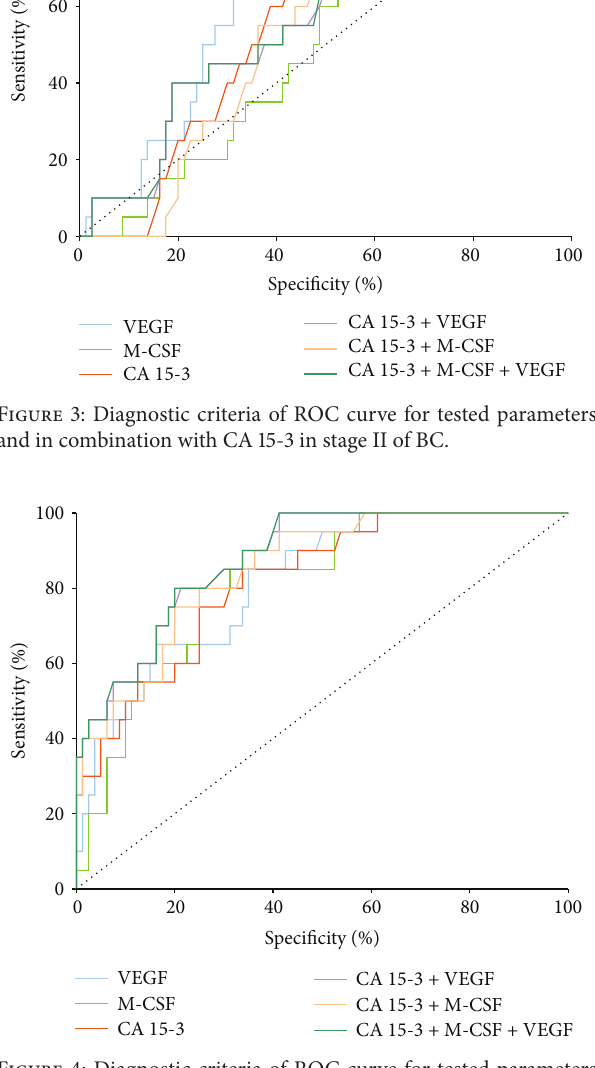
Figure 4: Diagnostic criteria of ROC curve for tested parameters and in combination with CA 15-3 in stage III of